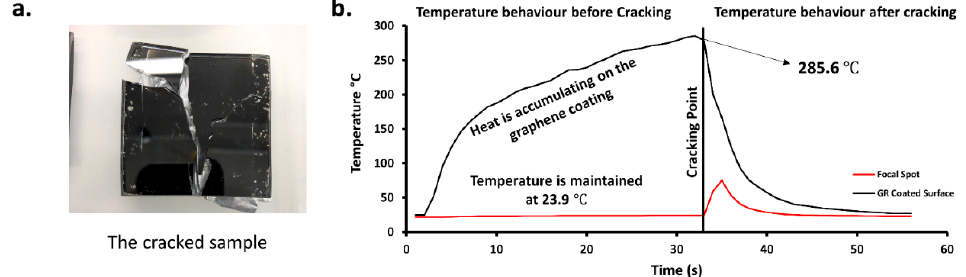
Figure 7. Thick GC sample facing the source of the solar irradiance showing ( a ) the breakage photograph and ( b ) the maximum temperature at the cracking point and the temperature behaviour.